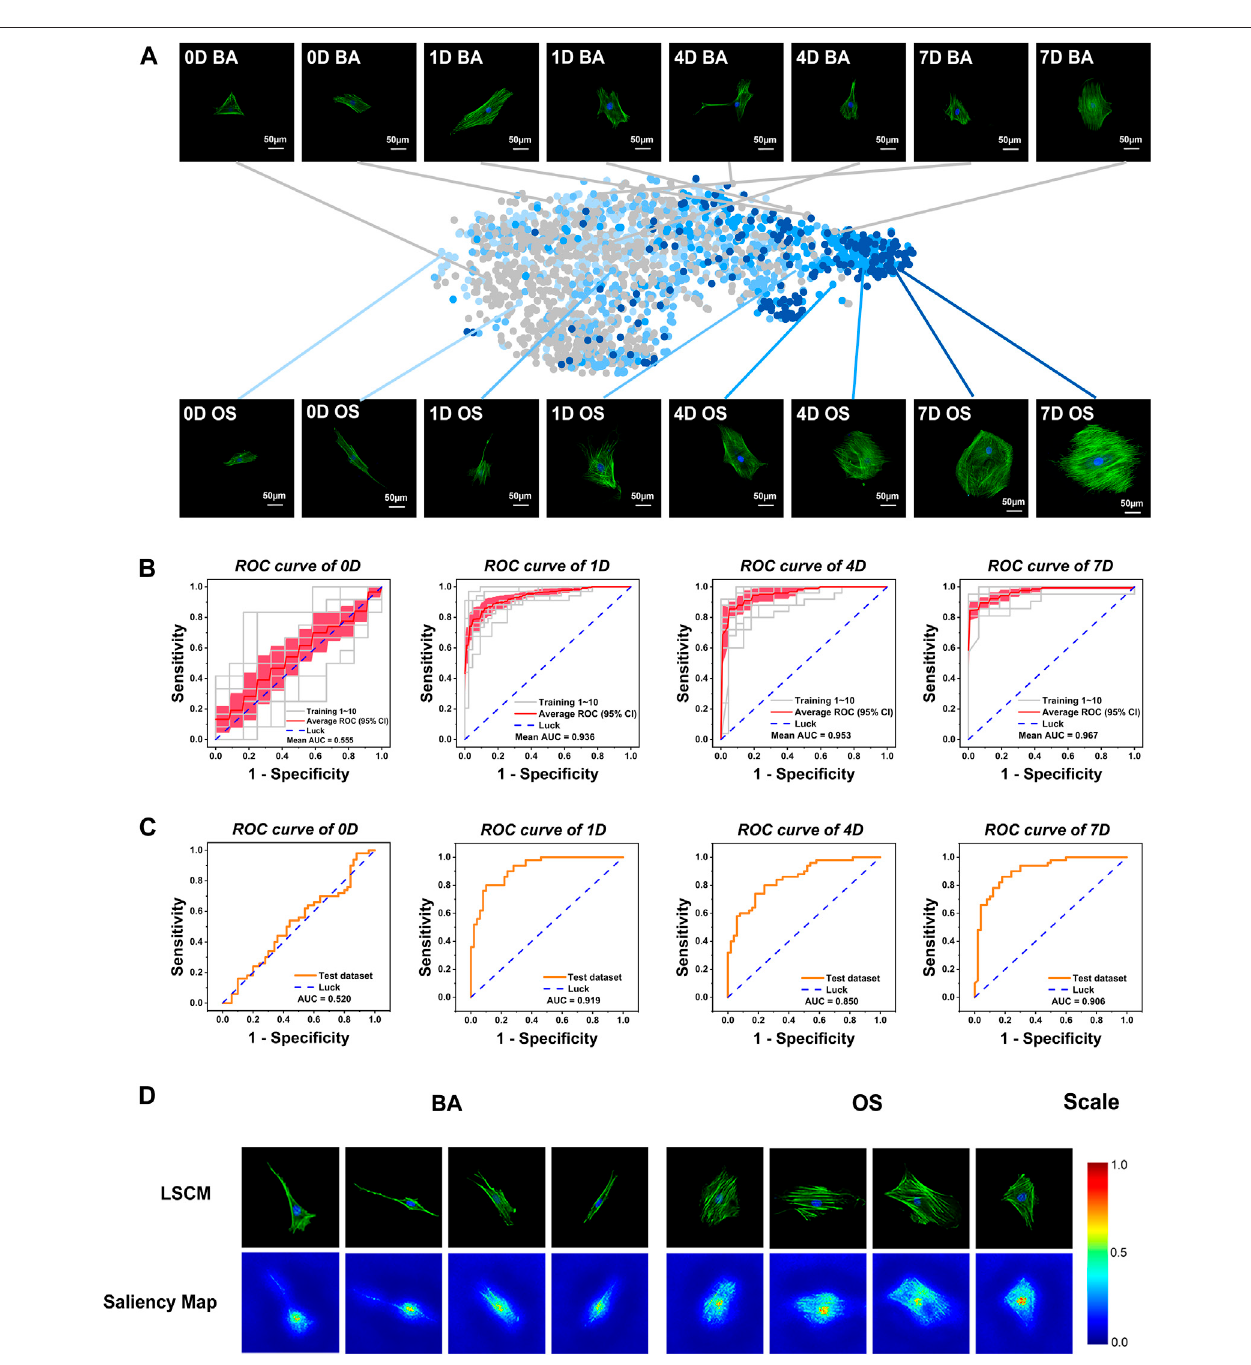
FIGURE2| Developmentandvalidationofaconventional,static,andbaselinemodel(OCNN)forsensitivehigh-throughputandautomaticosteogenesisprediction on fl at coverslips. (A) Visualization of diverse single-cell datasets. The styles from the network for all images in the cell dataset were embedded using t-SNE. Each point represents a different LSCM image. Grey: basic (BA) group; light to deep blue: osteogenic (OS) group on days 0,1,4, and 7. Each photo: green, F-actin; blue, nuclei. Scale bar, 50 µm. (B) 10-fold cross-validated ROC curves of Inception V3 at four-time points (validation dataset). The gray line represents each independent validation; the red line represents the average ROC; the light red area represents the 95% con fi dence interval. (C) A randomly selected new test dataset was used to evaluate the classi fi cation performance of OCNN (50 images of BA/OS group each). ROC curves at four-time points. The orange line represents the independent validation. (D) The saliency map showed key identi fi cation regions for the prediction of BA or OS cells.